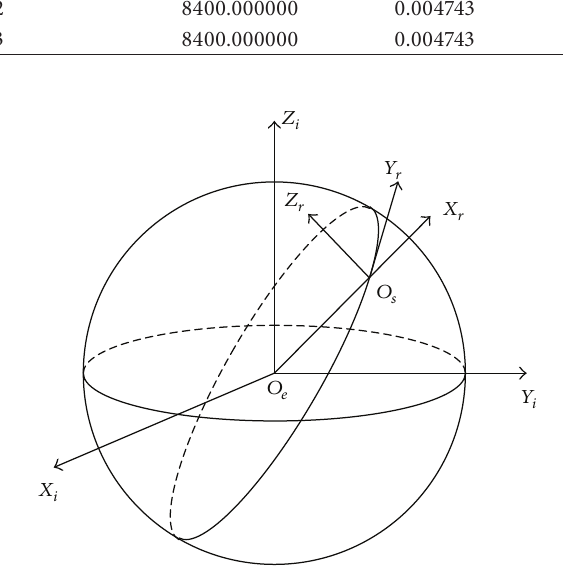
Figure 5: Relative coordinate system and ECI coordinate system. The relative coordinate system (or the Hill frame) is represented by − 𝑋 𝑌 𝑍 𝑂 𝑠 𝑟 𝑟 𝑟 , and the ECI coordinate system is represented by 𝑌 𝑍 𝑋 𝑖 𝑖 𝑖 .